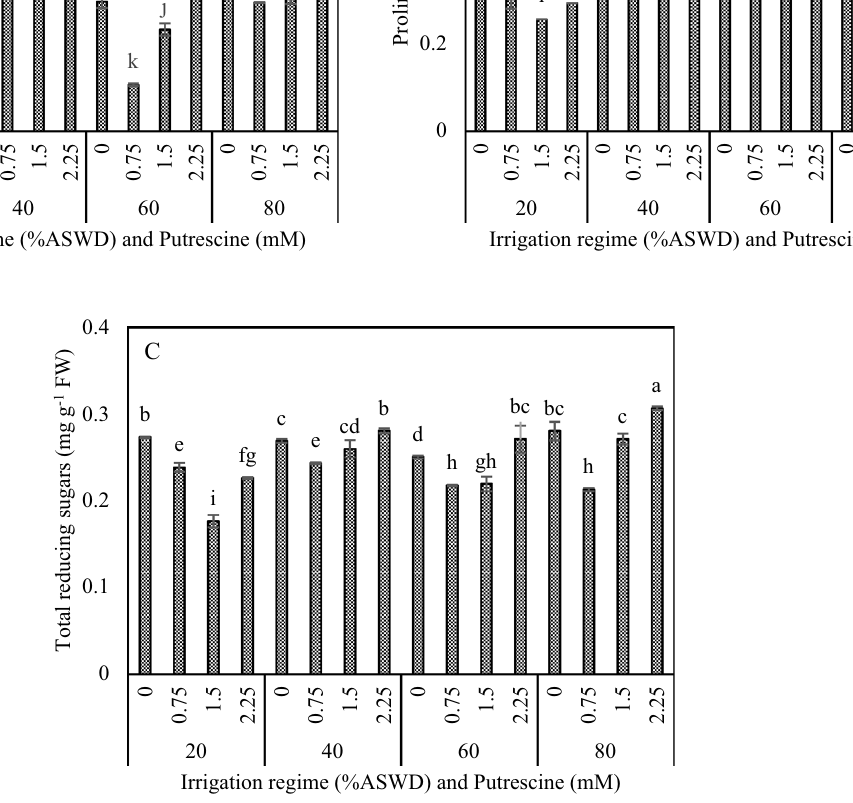
Figure 4. Interaction between irrigation regime and putrescine on glycine betaine ( A ), proline ( B ) and total reducing sugars ( C ). The different letters show significantly different at the level of 0.01. The error bars represent standard